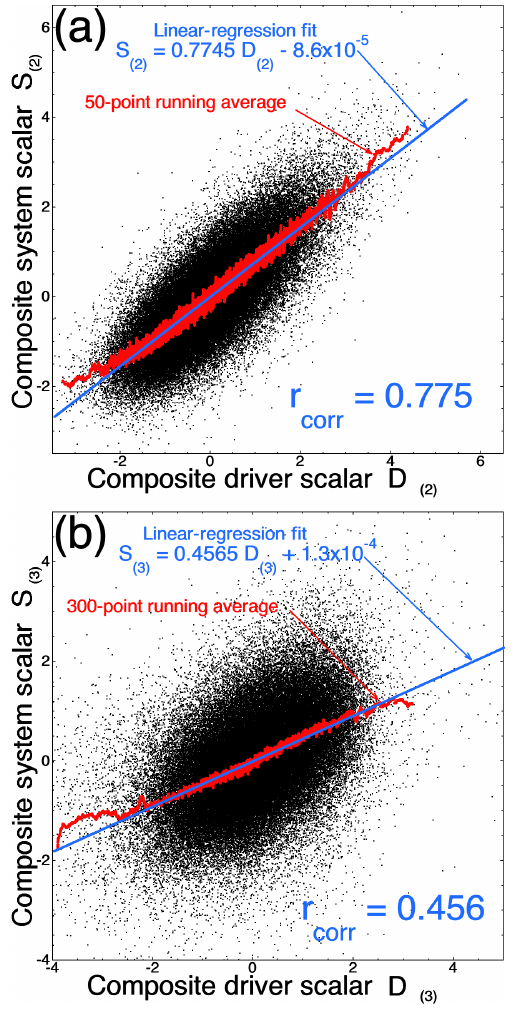
Figure 7. For the 1h resolution 1991–2007 data set, the aggregate system scalar S ( 2 ) is plotted as a function of the driver scalar D ( 2 ) in panel (a) and the aggregate system scalar S ( 3 ) is plotted as a function of the driver scalar D ( 3 ) in panel (b) . Each black point is 1h of